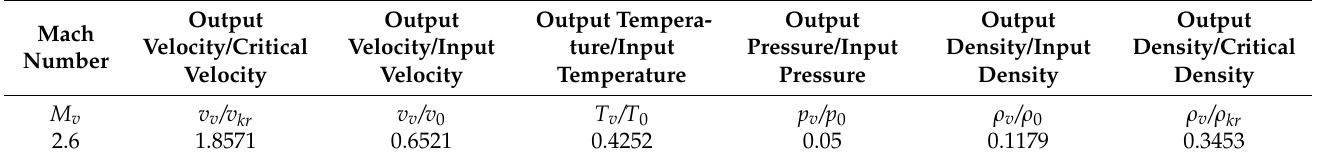
Table 1. Calculated values in critical input cross-section